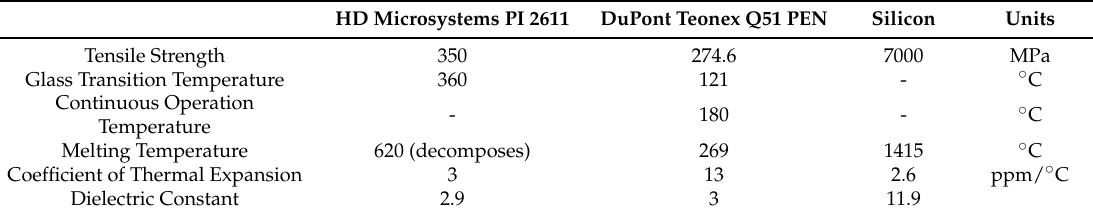
Table 1. Comparison of structural, thermal, and electrical properties of polyimide, polyethylene naphthalate (PEN), and